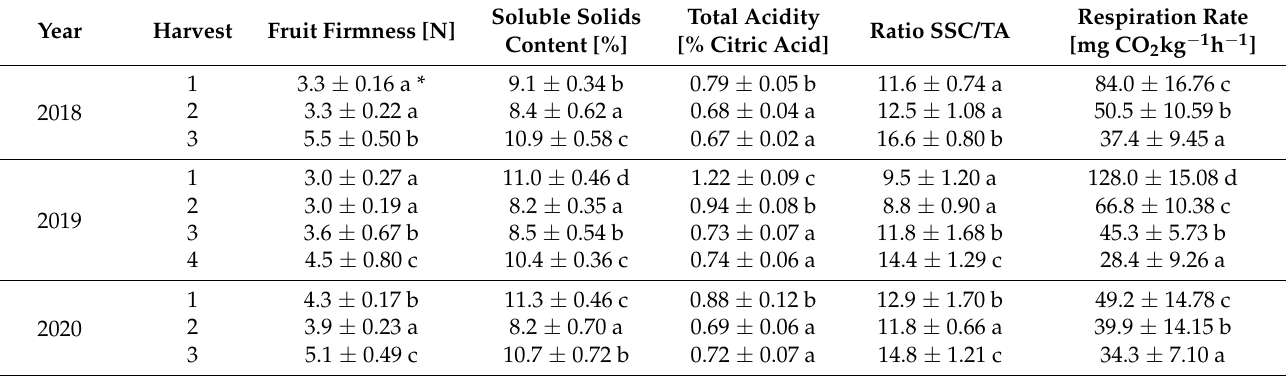
Table 3. Fruit quality of ‘Murano’ strawberries directly after